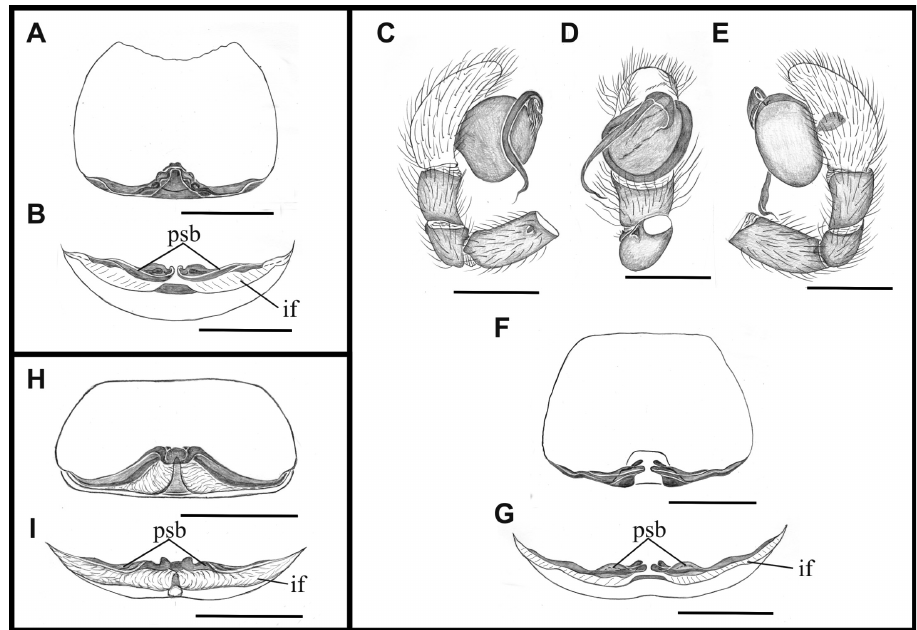
Figure 11. Nasutonops xaxado sp. n., female from Serra Talhada, Pernambuco ( A–B ) Nasutonops